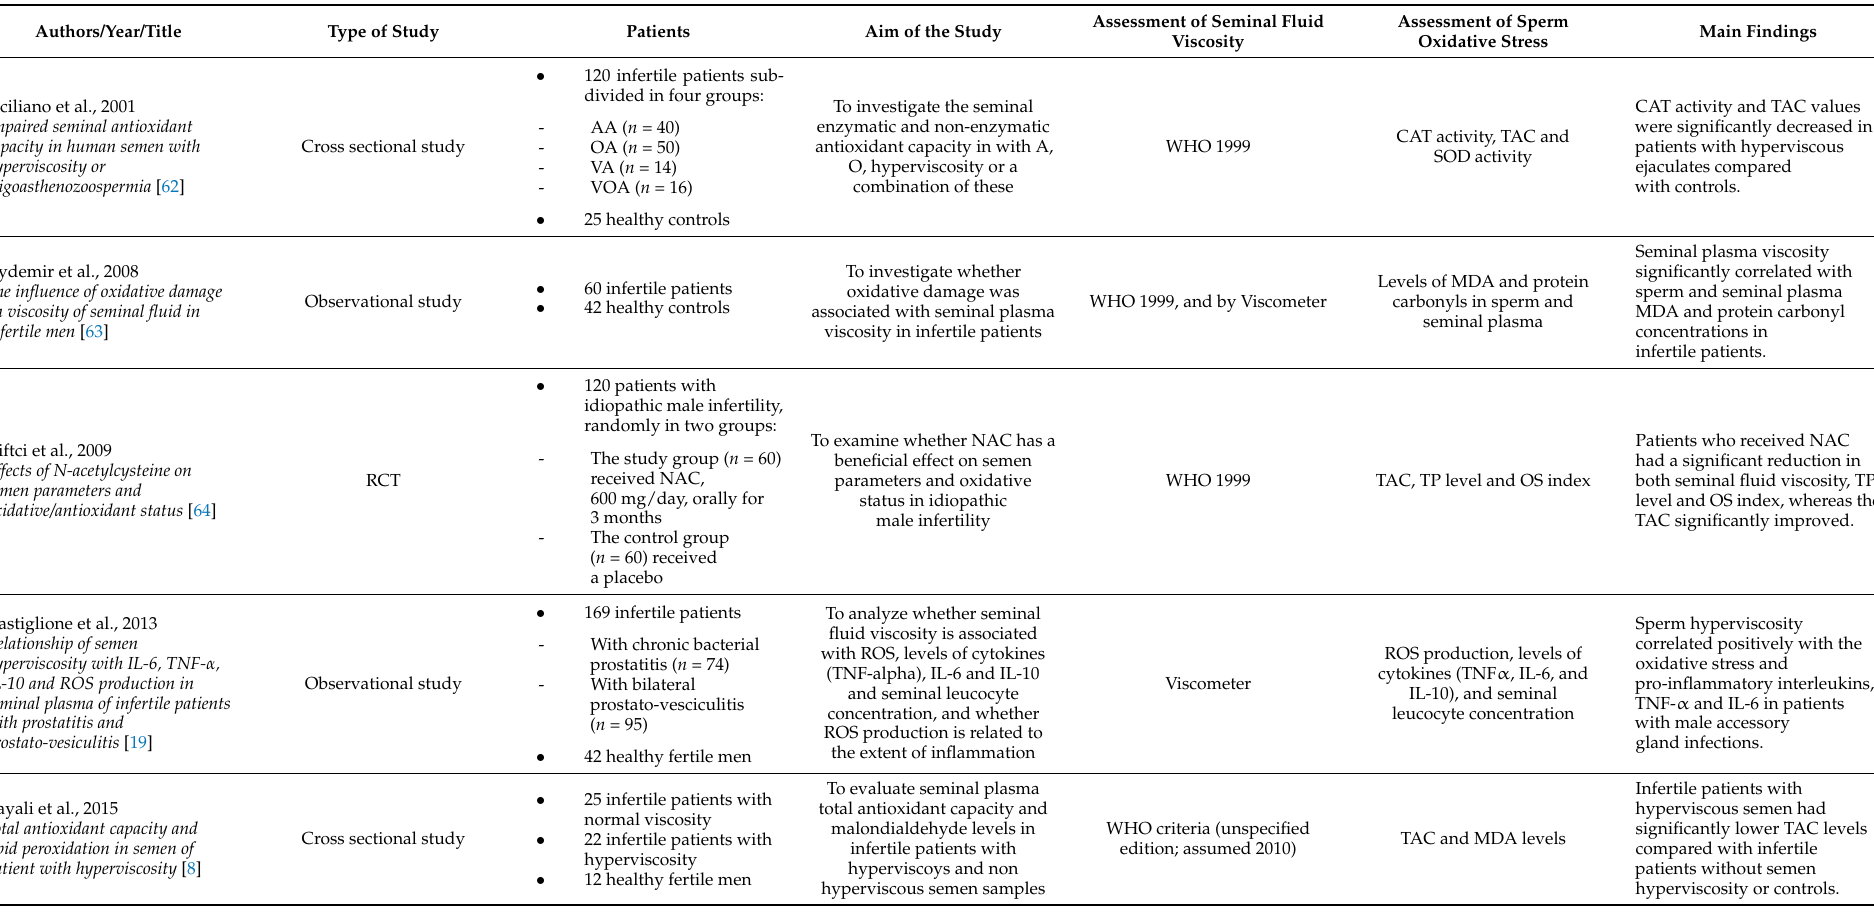
Table 1. Studies evaluating the relationship between seminal fluid viscosity and sperm oxidative